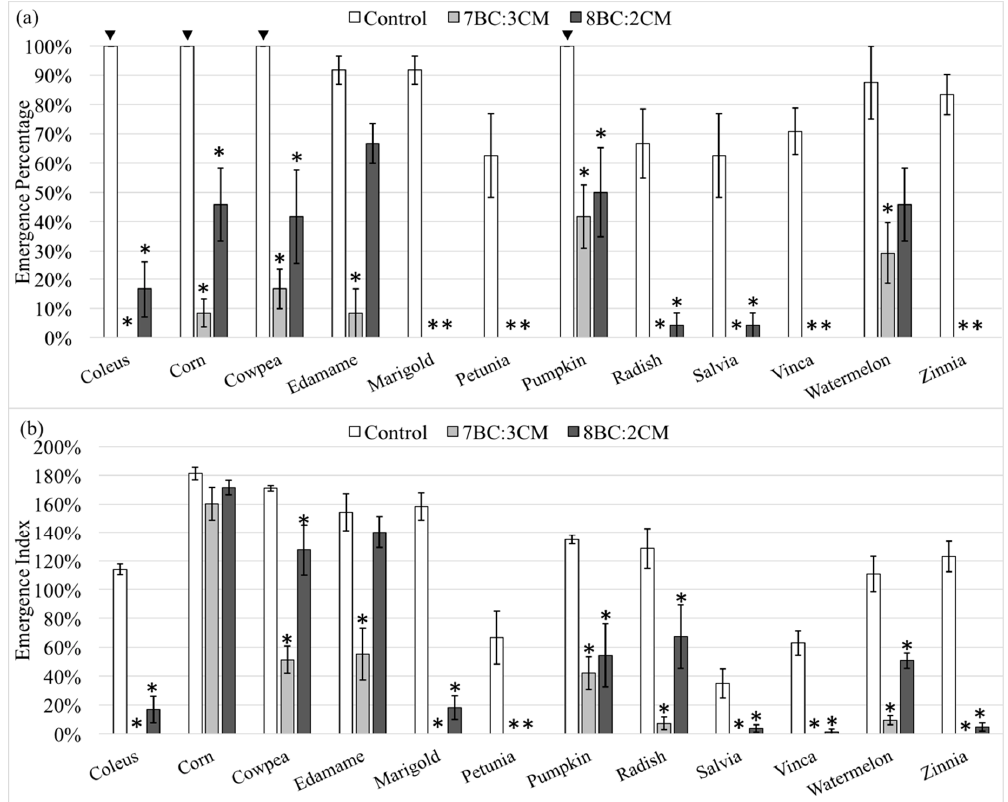
Figure 3. Seeds’ emergence percentages ( a ) and emergence indexes ( b ) (mean ± standard error) in commercial propagation mix (control), 70% biochar:30% chicken manure compost (7BC:3CM, by volume), or 8BC:2CM in Experiment 3. The asterisks (*) indicate differences from the control using Dunnett’s test at p < 0.05 ( n = 4). Means indicated by “(cid:31)” are 100% ± 0.